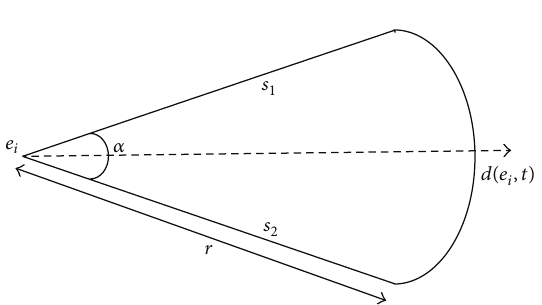
Figure 5: Front region of an entity 𝑒 𝑖 at a time-point 𝑡 .